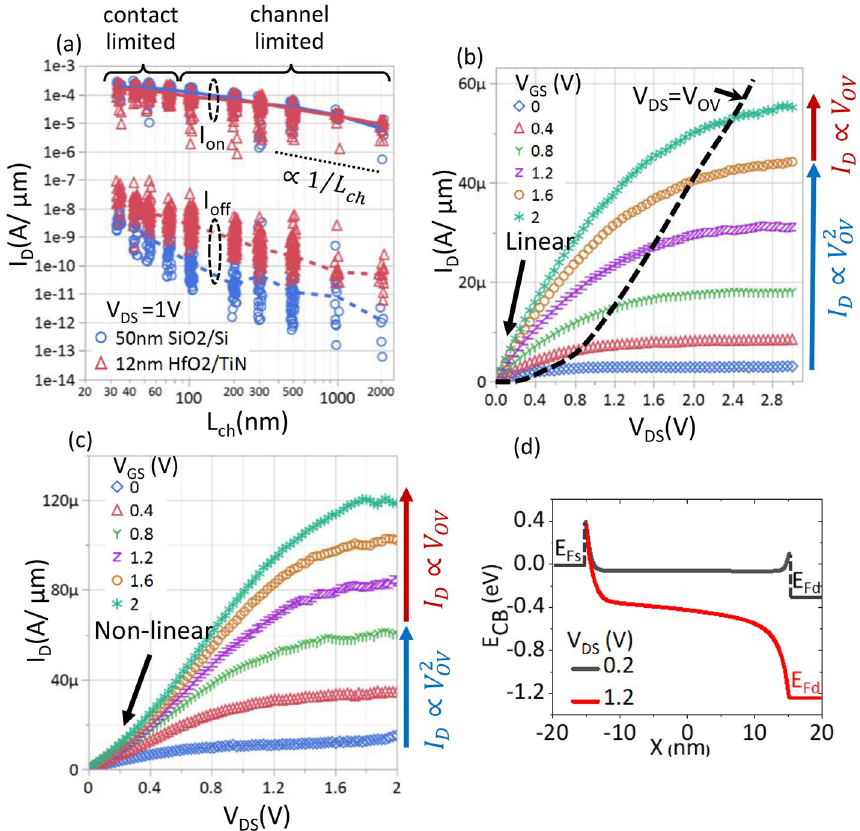
Figure 2. ( a ) Scatter plot (with median line) showing I on extracted at n s = 1e13 cm −2 and I off at a fixed displacement field of 0.4 V/nm below V T,CC. for V DS = 1 V. I on for the 50 nm SiO 2 and 12 nm HfO 2 devices overlap indicating no impact on low-field mobility and contact barrier. I on roughly scales as 1/L ch for L ch > 500 nm and saturates for L ch < 50 nm. I off is higher for HfO 2 compared to SiO 2 . ( b ) I D -V DS for L ch = 500 nm shows linear triode regime and saturation at high V DS . The dashed line follows the current at V DS = V OV. While the onset of saturation follows the V OV at low V GS , it saturates at V DS = 2.4 V for high V GS . The saturation current roughly scales V OV 2 and V OV 1 , at low and high V GS , respectively. ( c ) I D -V DS for L ch = 30 nm shows non-linear triode regime due to Schottky contacts and saturation at high V DS . Saturation current follows a similar trend as L ch = 500 nm but V DS at onset of velocity saturation is reduced to 1.4 V. ( d ) Conduction band profile for L ch = 30 nm device with Schottky contacts shown for low and high V DS . The Fermi-level at the source and drain are indicated by E FS and E FD , respectively. The Schottky barrier is shown as the abrupt potential change at the contact-channel interface. At low V DS, I DS is determined by Schottky contacts. At high V DS , though the potential drops significantly at the source contact, velocity saturation or pinch-off near the drain determines the I D